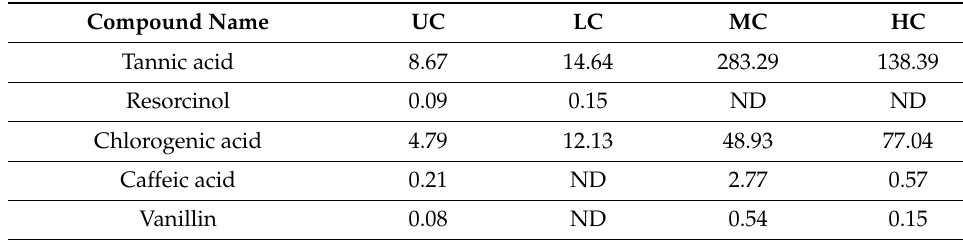
Table 3. Concentration of phenolic compounds in air-fried eggplant (mg/100 g dry weight); ND: not detected.